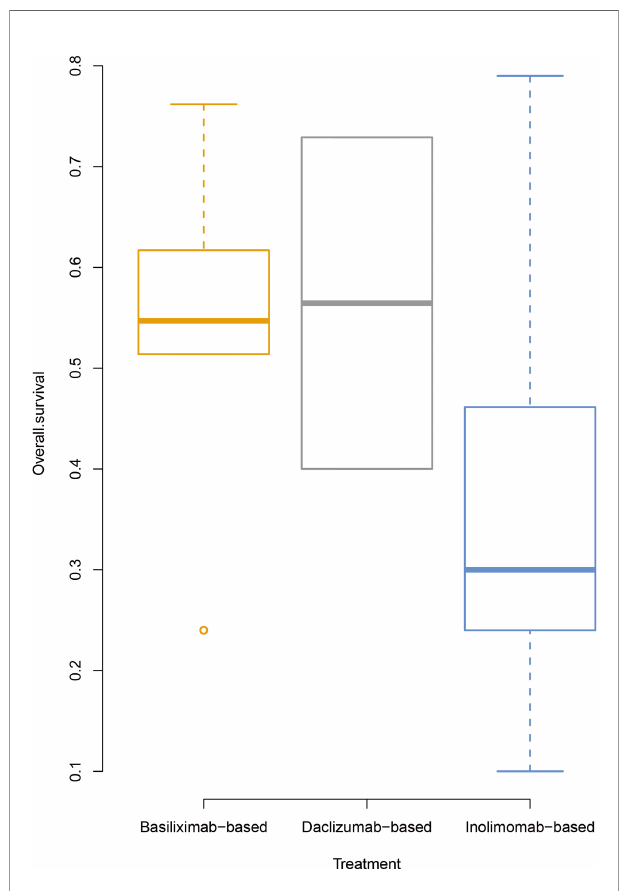
FIGURE 4 | Overall survival rates of patients after treatment with